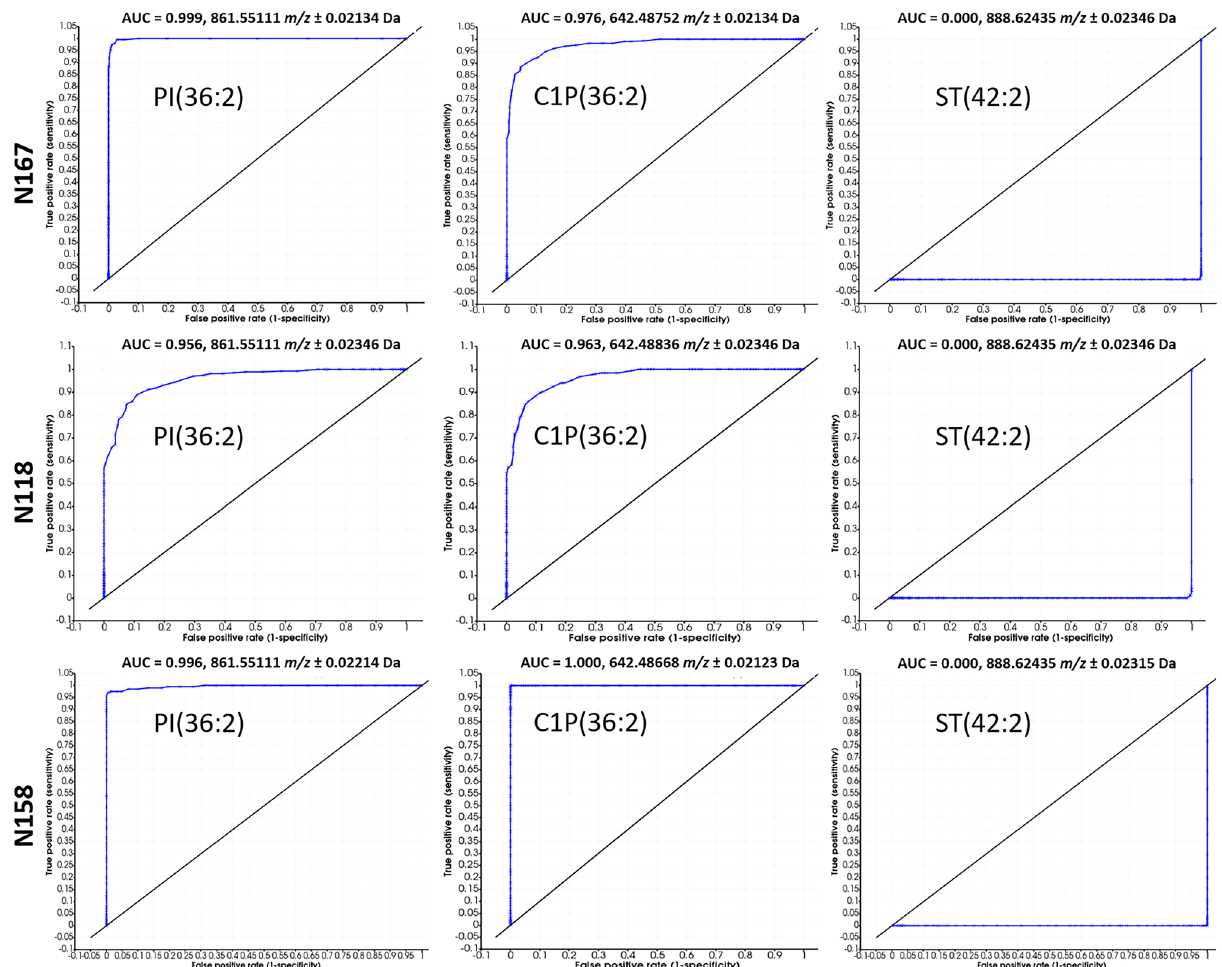
Figure 7. Example AUC—ROC plots for PI(36:2), C1P(36:2) and ST(42:2). Plots for N167 and N118 = high tumor cell density and high proliferation index vs. moderate tumor cell density and low proliferation index. Plots for N158 = high tumor cell density and high proliferation index vs. low tumor cell density and low proliferation index. PI(36:2) and C1P(36:2) ( m/z 861.551 and 642.488 respectively) with AUC ≥ 0.956 discriminate high tumor cell density/high Ki67 regions, while ST(42:2) ( m/z = 888.642) with AUC = 0 discriminates moderate and low tumor cell density regions/low Ki67